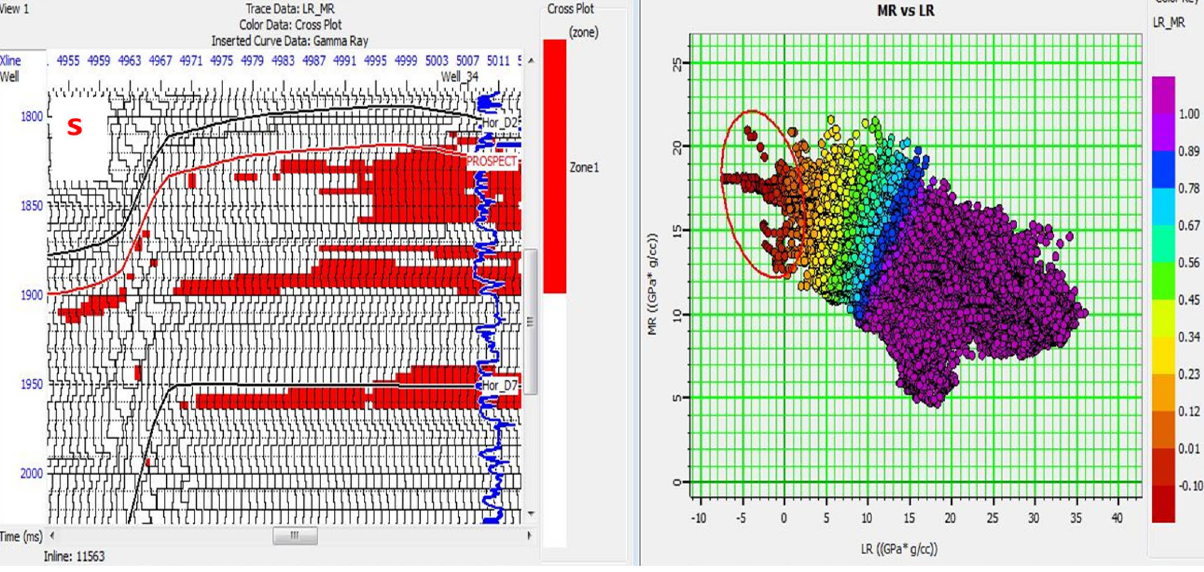
Fig. 12 Plot of Mu-Rho versus Lambda-Rho color coded with Lambda-Rho/Mu-Rho ratio for Inline 11,563 confirming D2 reservoir to be hydrocarbon bearing in the prospective